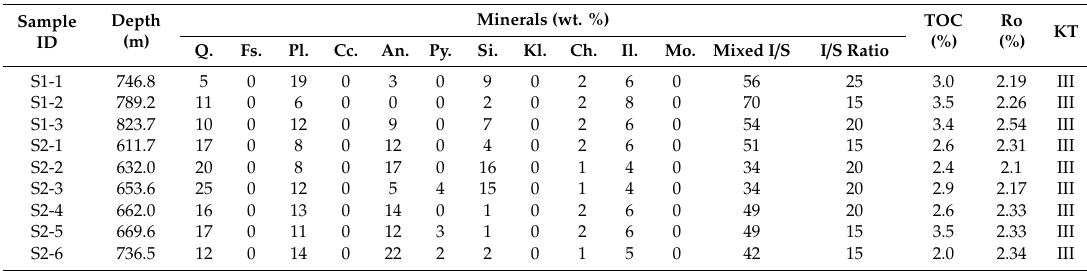
Table 1. XRD analysis and organic geochemical analysis results of the shale samples from the Laochang area, eastern Yunnan,